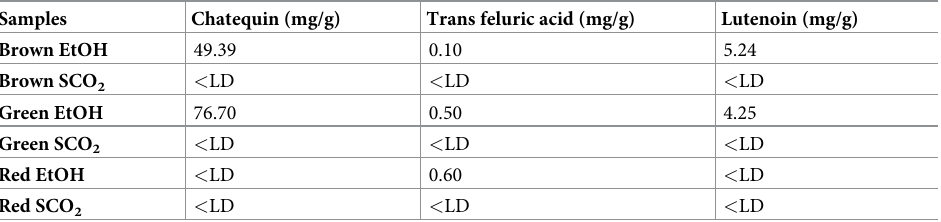
< LD < LD EtOH–Extracts obtained by ethanolic extraction; SCO 2 –Extracts obtained by SFE (CO 2 as supercritical fluid); < LD: below detection levels.